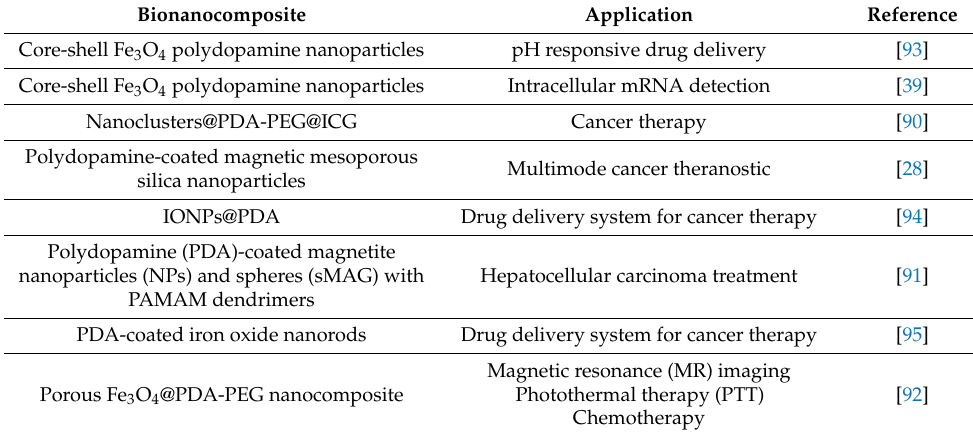
Table 2. Fe 3 O 4 @PDA nanocomposites for biomedical